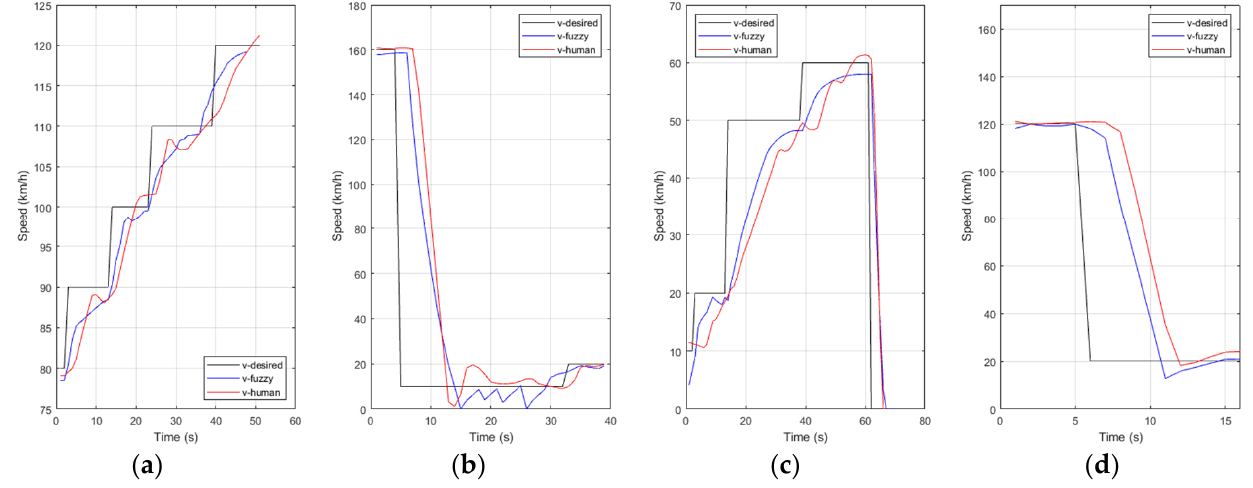
Figure 5. ( a–d ) Behavior of fuzzy control model compared with subjects’ driving behavior. Figure 5. ( a – d ) Behavior of fuzzy control model compared with subjects’ driving